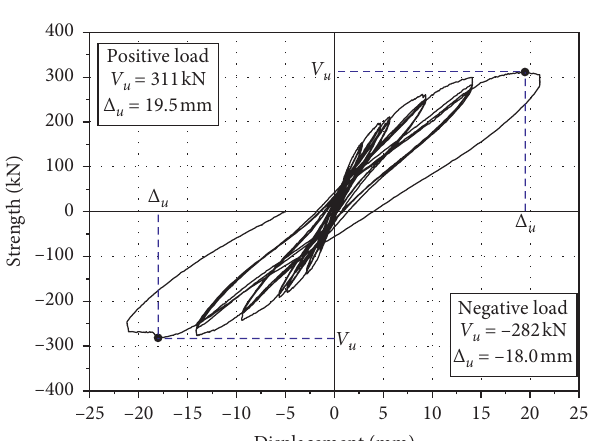
Figure 10: Lateral load-displacement curve for the C-RC specimen during the cyclic loading test. V placement at the ultimate point.